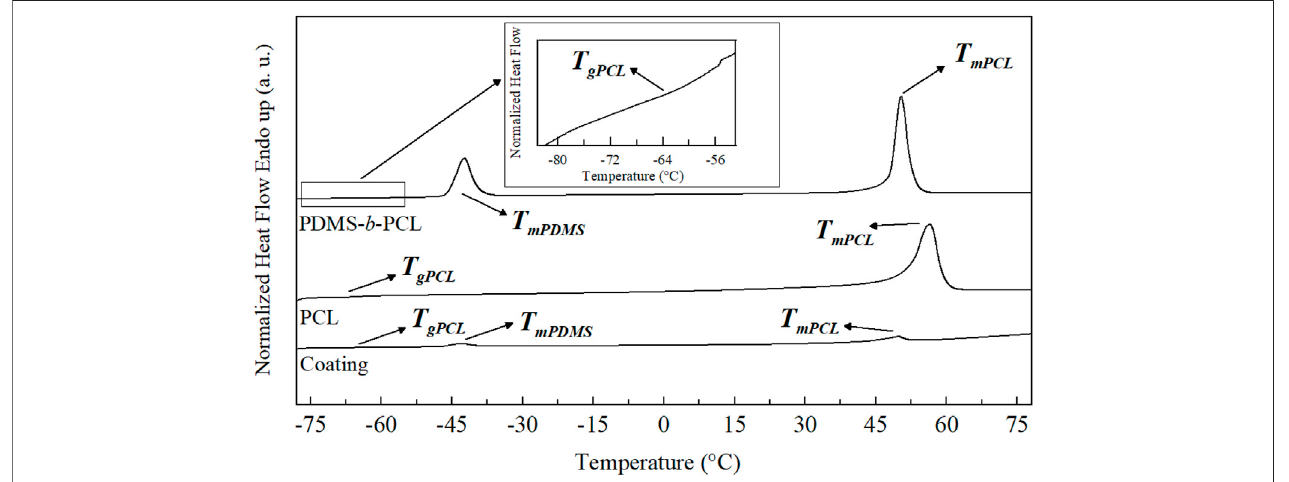
FIGURE 5 | Thermal transitions of PDMS- b -PCL copolymer, PCL homopolymer, and coating (before soaking in SBF solution) by DSC.